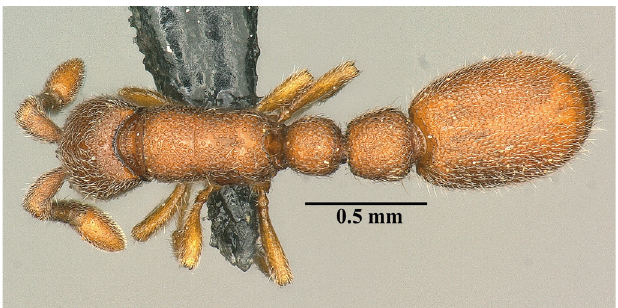
Fig 2 . Ooceraea octoantenna Zhou & Chen sp. nov., worker holotype, body in dorsal